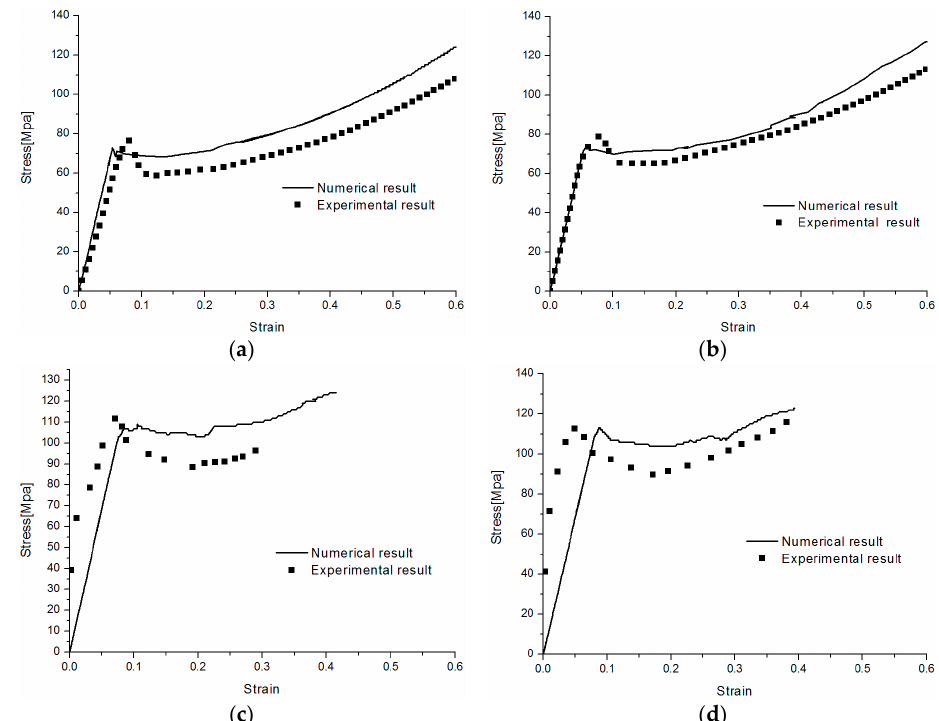
Figure 11. Numerical predictions and experimental results of stress–strain responses of PC at different strain rates: ( a ) 0.01 s − 1 ; ( b ) 0.1 s − 1 ; ( c ) 3500 s − 1 ; and ( d ) 4500 s − 1 .